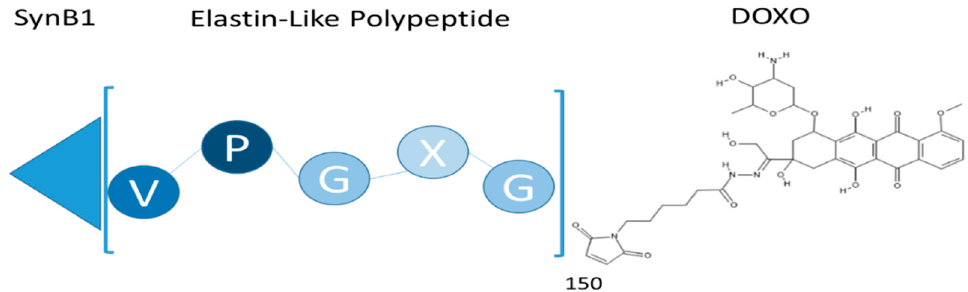
Figure 1. Elastin like polypeptide: Conjugate structure is composed of the cell penetrating peptide (SynB1), elastin-like polypeptide (ELP), and DOXO-EMCH (Doxo). MW = 60 kDa.